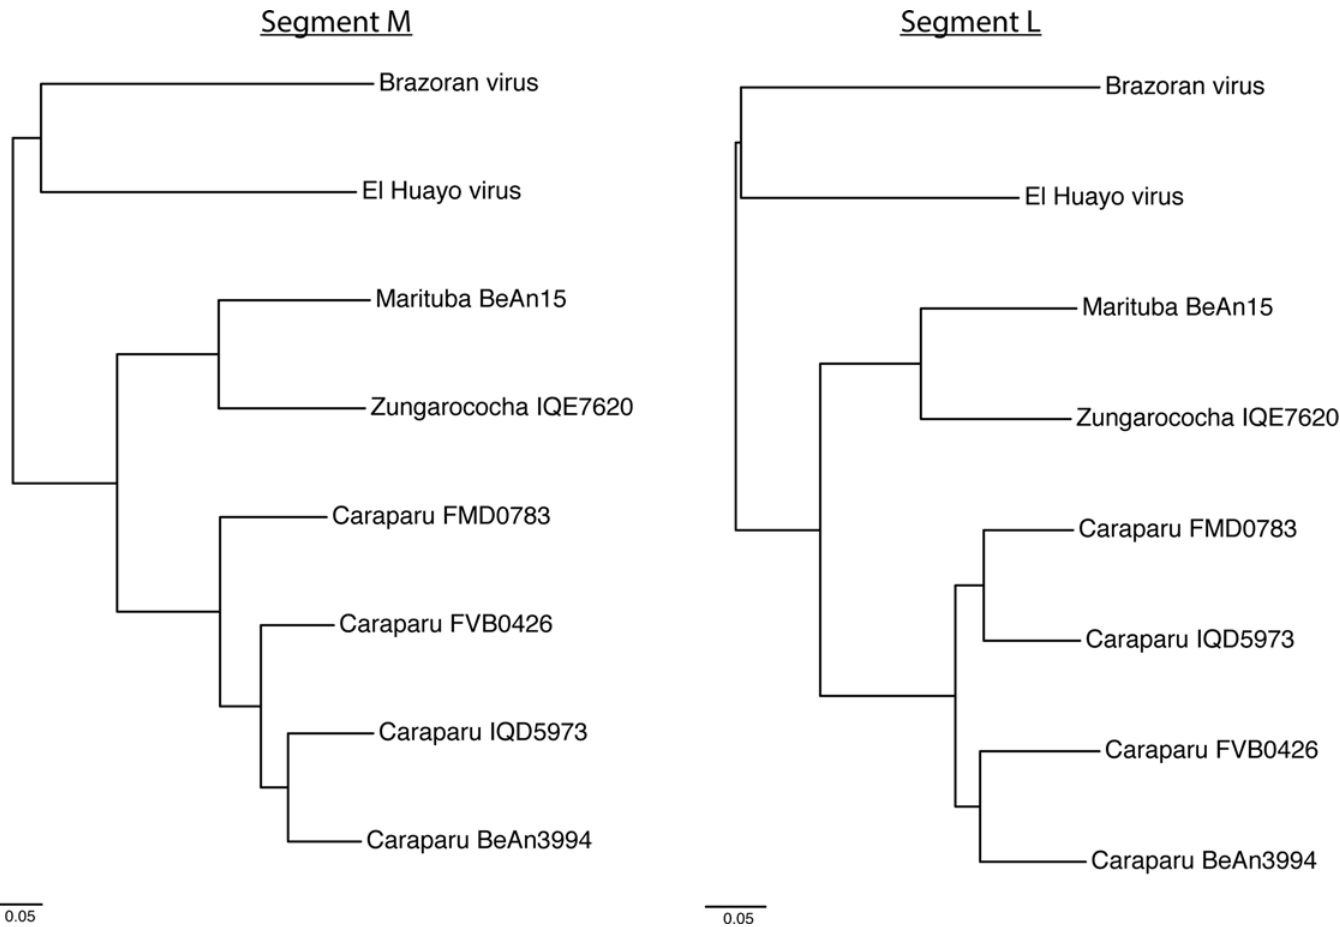
Fig 2. Group C phylogeny of orthobunyaviruses listed in Table 2, for both segment M and L. S segment not shown due to partial assembly (608 nt out of 1000 – 1100 nt). Nodes with low bootstrap support (less than 0.8, Shimodaira- Hasegawa) are colored red.